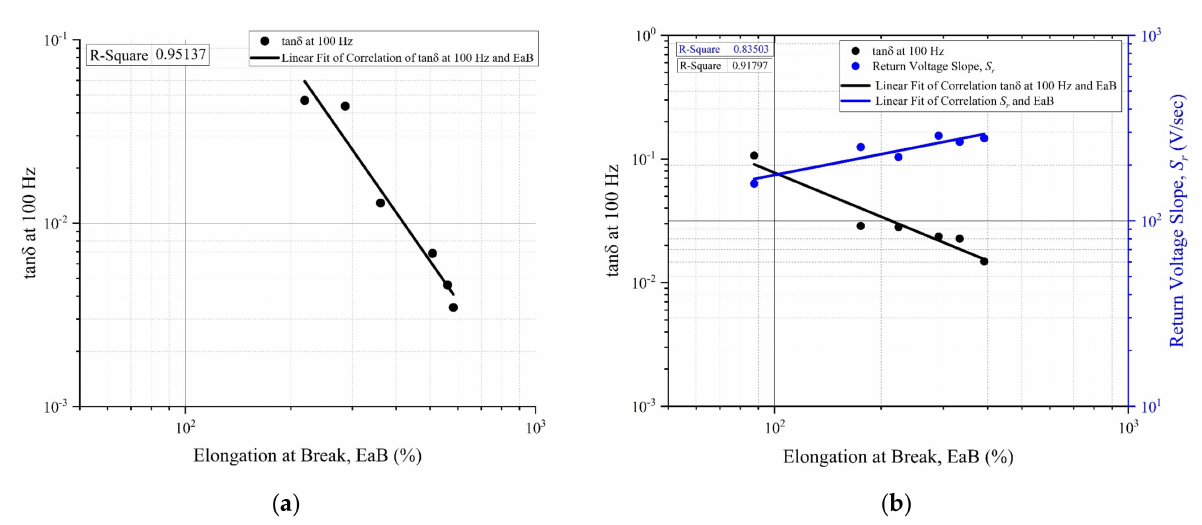
Figure 15. Correlation between tan δ at 100 Hz: ( a ) EPR insulation and tan δ at 100 Hz and S r at 1 s and ( b ) CSPE jacket against